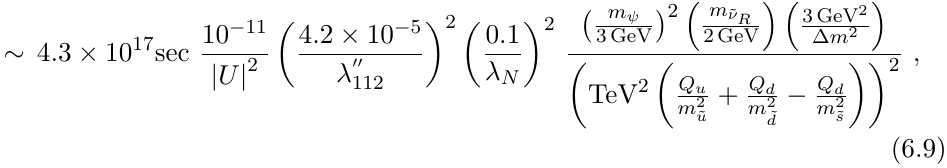
. Propagator arrows indicate the (cid:13)ow of 112